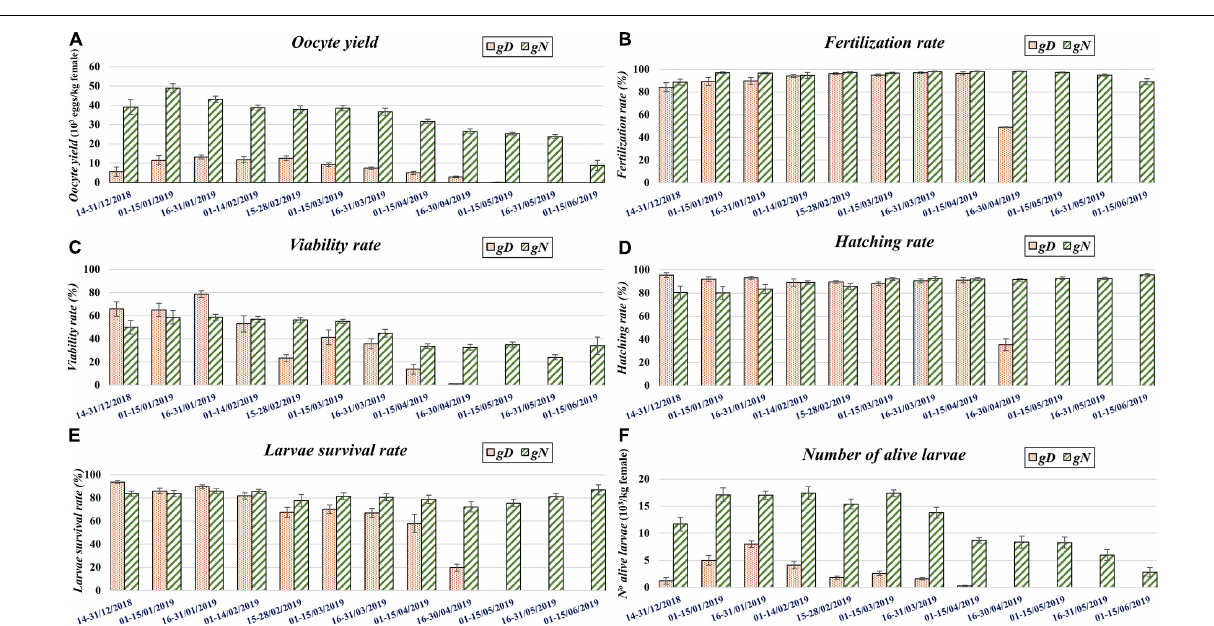
FIGURE 4 | The evolution of the quality and quantity of spawning traits per genetic group ( gD , gN ) by fortnight, throughout the spawning season. Each capital letter corresponds to a trait: (A) oocyte yield , (B) fertilization rate , (C) viability rate , (D) hatching rate , (E) Larval survival rate , (F) Number of alive